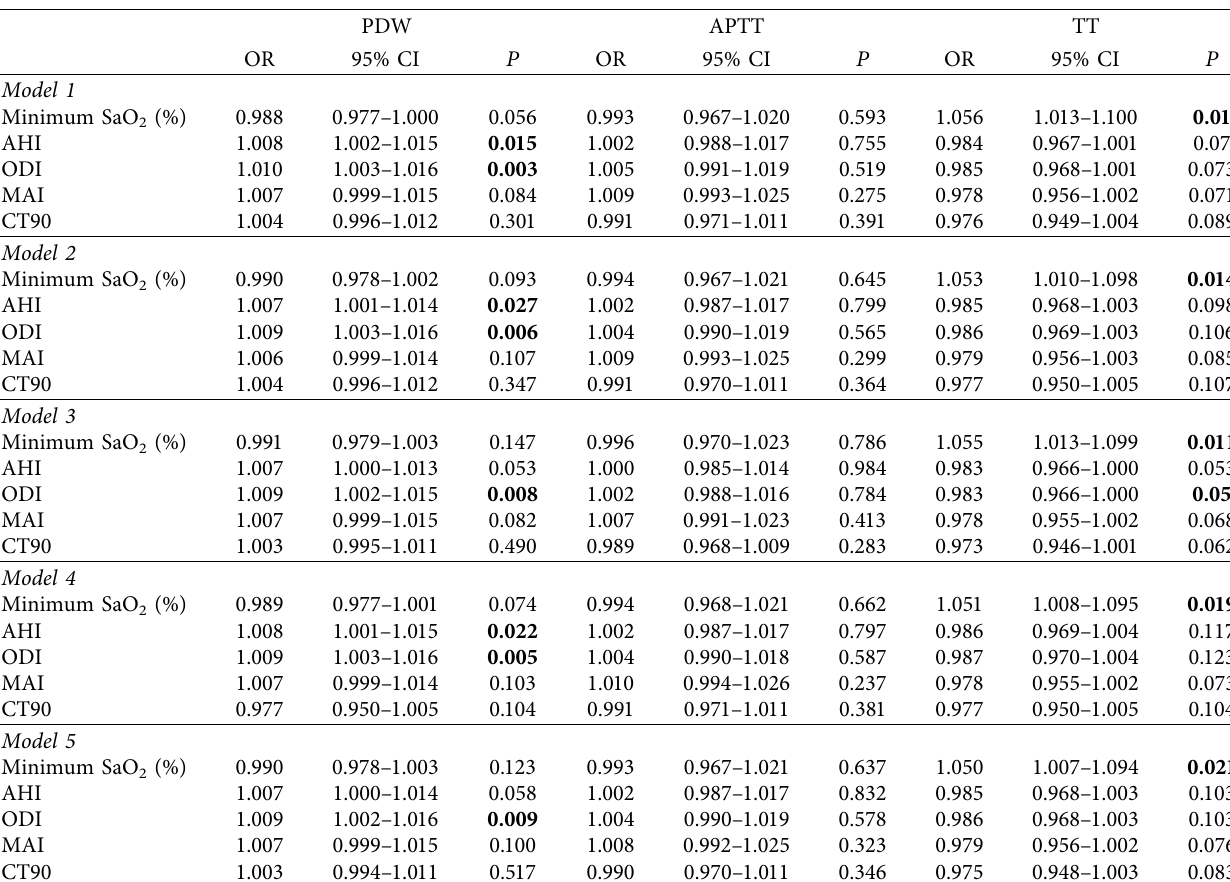
Table 3: Associations of OSA-related traits with the risk of